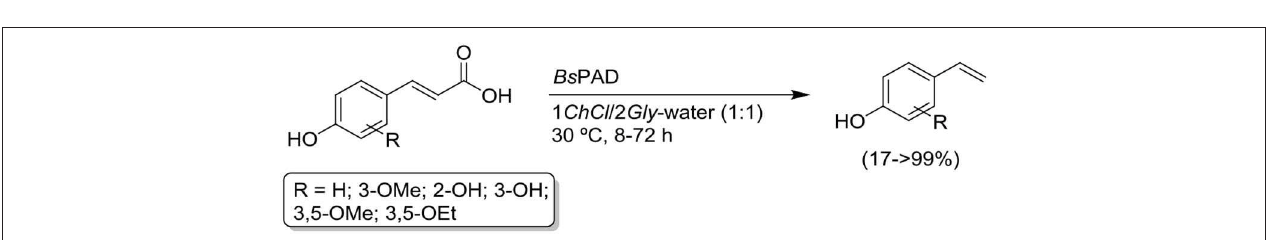
SCHEME 1 | Previous reported examples on chemoenzymatic cascades in DESs